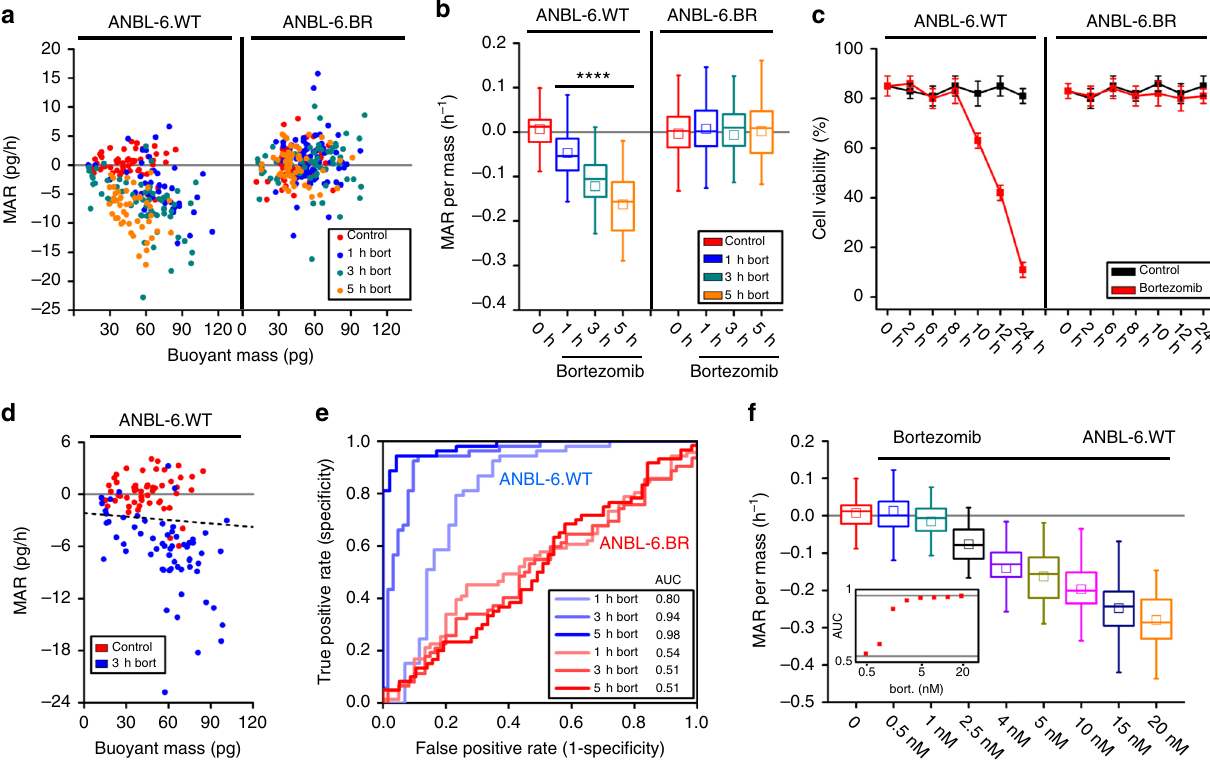
Fig. 2 Human multiple myeloma ANBL-6 cells rapidly reduce MAR upon exposure to proteasome inhibition. a MAR vs. mass plot for bortezomib-sensitive (ANBL-6.WT) and bortezomib-resistant (ANBL-6.BR) cells exposed to 5 nM bortezomib (bort) with 1, 3, and 5 h-long treatment duration. b Same data as in a shown as MAR per mass box plot. Boxes represent the inter-quartile range and white squares are the average of all MAR measurements. Welch ’ s t -test has been used to calculate p values, comparing treatment groups to 0-h control. **** p < 10 − 4 in highlighted segments. All treatment groups for the ANBL-6.WT cells have p < 10 − 5 , where for the bortezomib exposure from 1 to 5 h; p (control vs. 1-h. bort.) = 4.8 × 10 − 5 , p (control vs. 3-h. bort.) = 5.3 × 10 − 16 , and p (control vs. 5-h. bort.) = 4.7 × 10 − 26 . From left to right, number of cells in MAR measurements; n (ANBL-6.WT) = 53, 43, 62, 47 and n (ANBL-6.BR) = 59, 72, 62, 57. c Cell viability by trypan blue showing the increase in the cell death for ANBL-6.WT upon exposure to bortezomib, while ANBL-6.BR cells are unaffected. Error bars represent three times the standard deviation with n = 3 for each condition. d Representative MAR vs. mass plot with overlay of an orthogonal vector (black dotted line), which designates the threshold resulting from LDA. e ROC curves of control ( t = 0 h) and treatment (bortezomib) group for ANBL-6.WT and ANBL-6.BR cells at different treatment duration ( t = 1, 3, 5 h). Cells, which are sensitive and resistant to drug therapy, are shown with blue and red lines, respectively. f MAR per mass plot for ANBL-6.WT cells exposed to different bortezomib concentrations, between 0.5 and 20 nM under 5 h-long treatment, showing the further reduction for larger bortezomib concentration. Figure inset shows the calculated AUC values for each bortezomib concentration, where AUC converges to 1 with increasing bortezomib concentration. Number of cells in